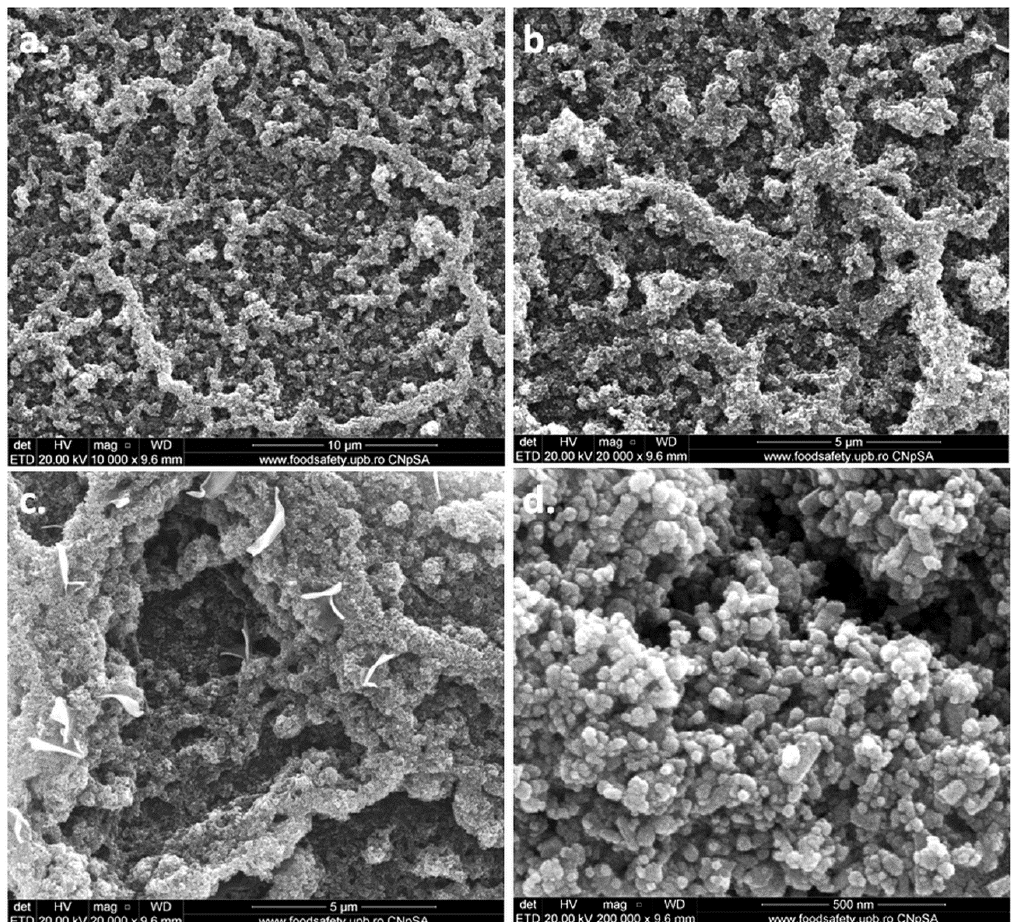
Figure 13. SEM images of PHB ‒ 2BC nanocomposite after ZnO plasma coating.